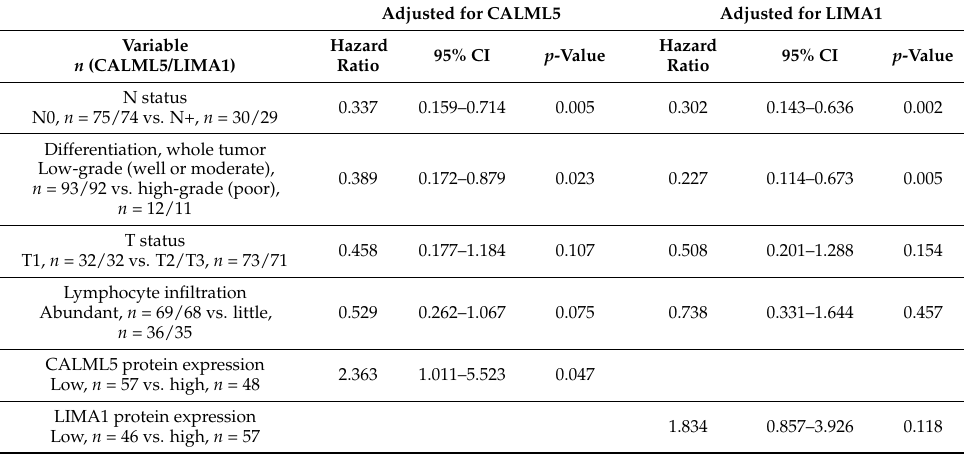
Table 6. Multivariate analysis of 5-year disease-specific survival in the oral tongue squamous cell carcinoma (OTSCC) cohort in accordance with Cox’s proportional hazards model. N status, tumor differentiation, T status, and lymphocyte infiltration were adjusted for CALML5 and LIMA1 separately. Only patients with data for all respective variables were included ( n = 105 and n = 103 for CALML5 and LIMA1,